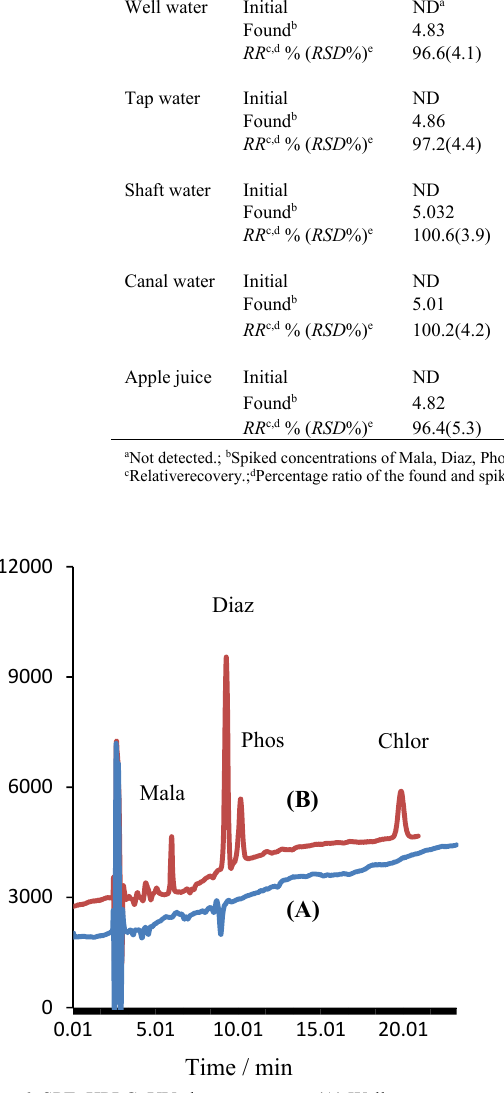
Table 2: Results of determination and recoveries of various real samples spiked with OPPs. Samples